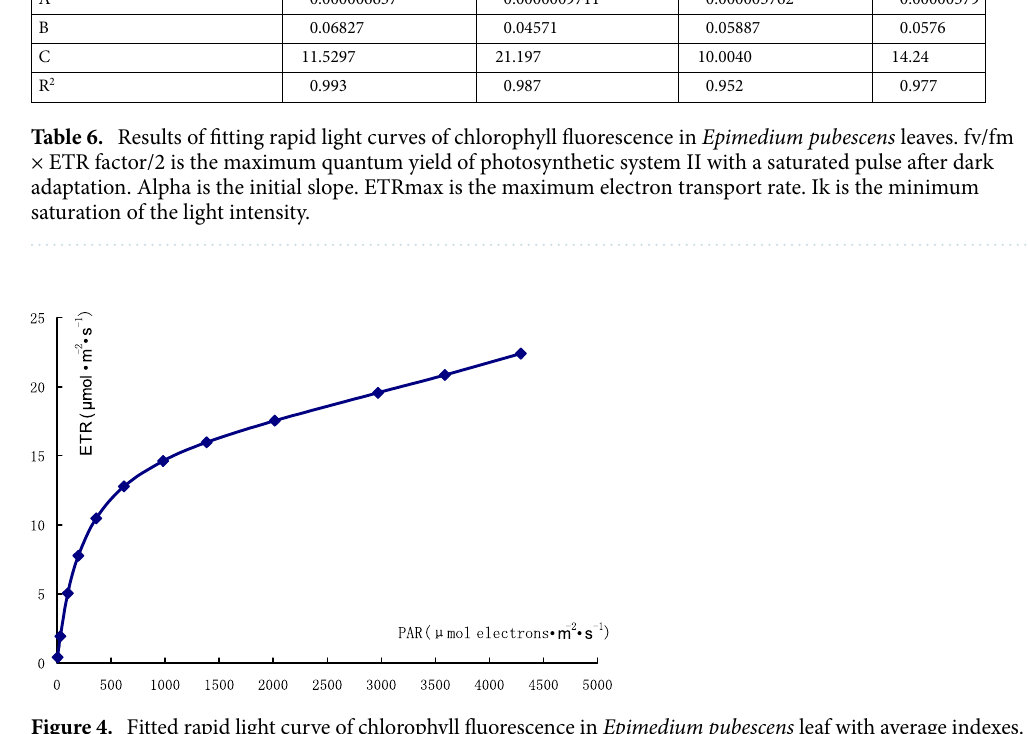
Figure 4. Fitted rapid light curve of chlorophyll fluorescence in Epimedium pubescens leaf with average